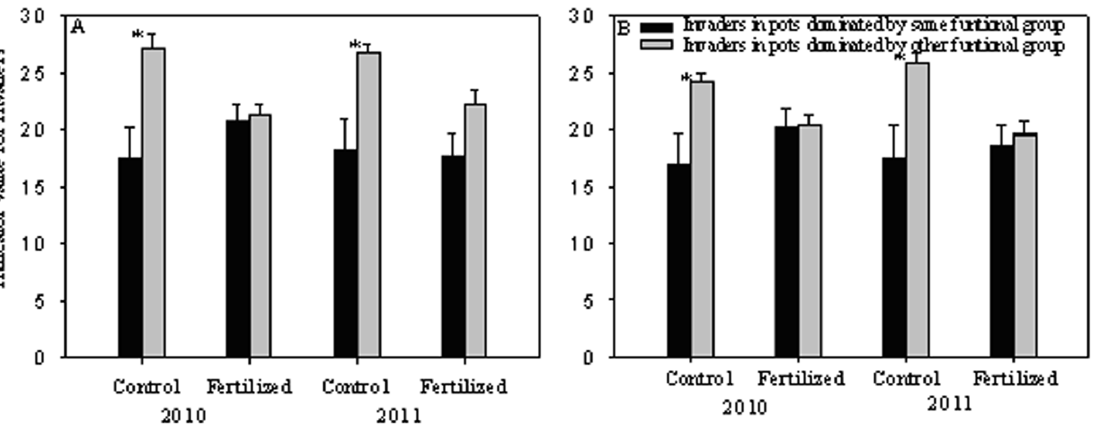
Figure 3. The indicator value (IV) of invaders for coverage (A) and seedling number (B) in the pots dominated by same functional group and the pots dominated by other functional group in 2010 and 2011. Higher indicator values represent higher colonization success. *indicate significant difference between the pots dominated by same functional group and the pots dominated by other functional group.